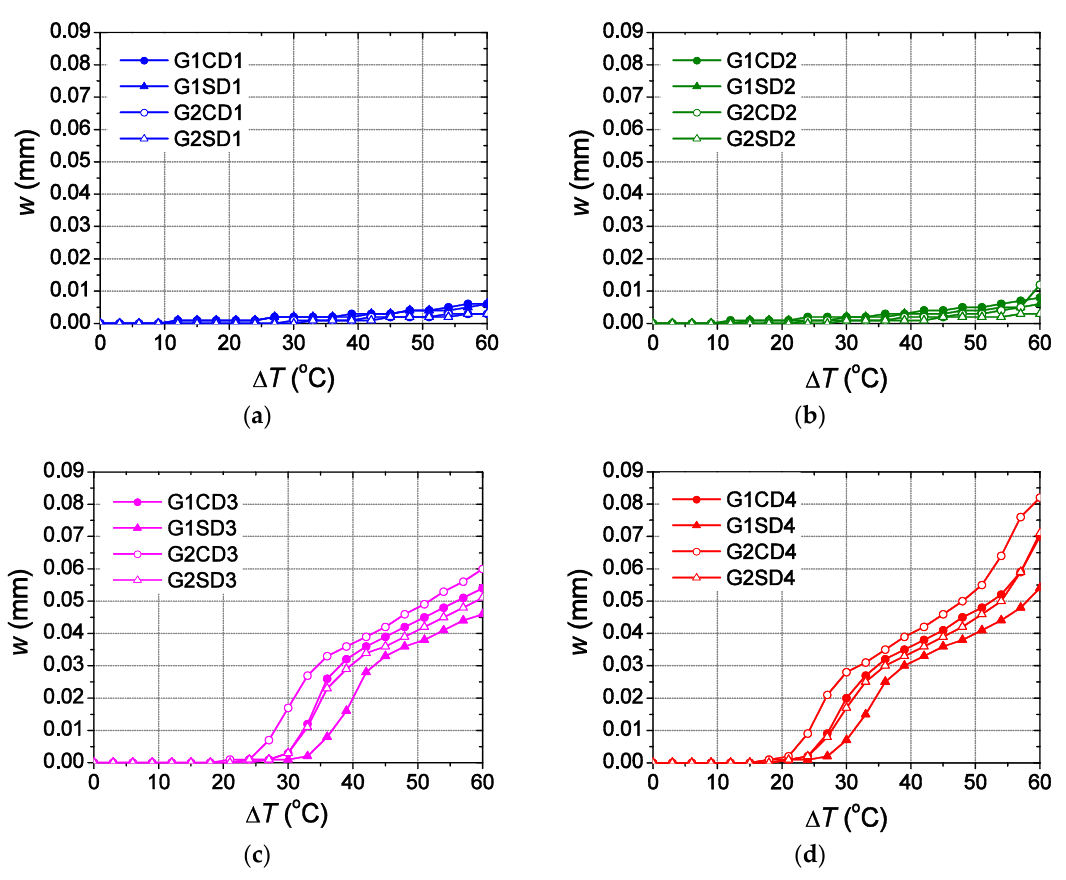
Figure 7. Evolution of the maximum crack opening in Z3 for the different type of dowels: ( a ) D1; ( b ) D2; ( c ) D3; ( d ) D4.